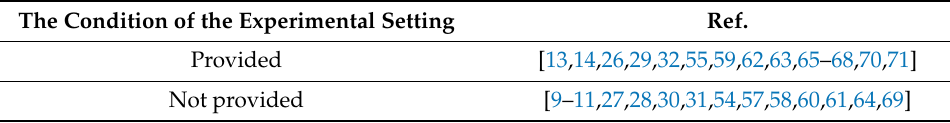
Table 6. The results of the quality assessment in the Included Study .